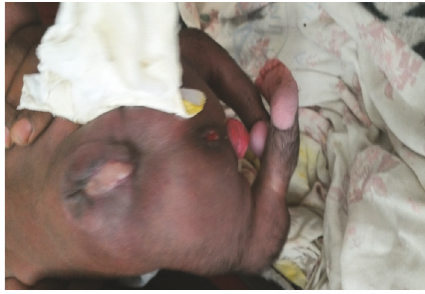
Figure 2: Picture of the spinal cord defect, uterovaginal prolapse, and club feet.